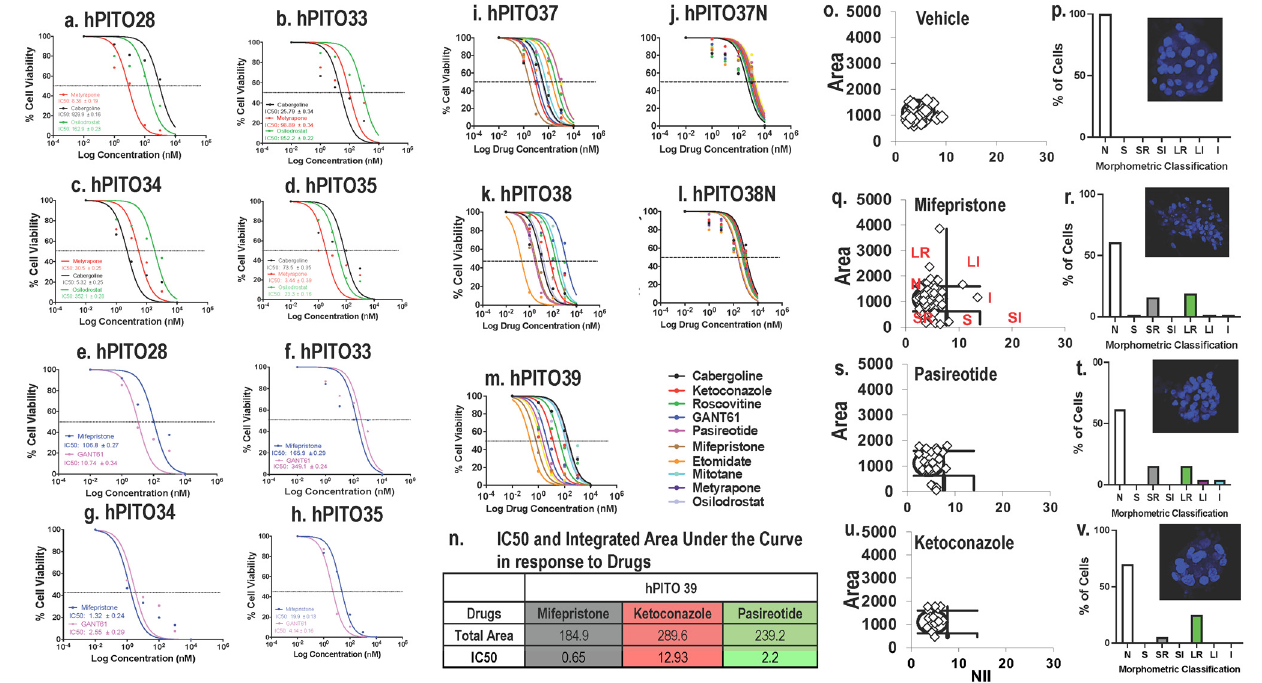
Figure 4. Drug dose responses by hPITOs generated from CD patients. Dose responses to mifepris- tone, GANT61, cabergoline, and osilodrostat. ( a , e ) hPITO28, ( b , f ) hPITO33, ( c , g ) hPITO34, and ( d , h ) hPITO35. Dose responses to cabergoline, ketoconazole, roscovitine, GANT61, pasireotide, mifepris- tone, etomidate, mitotane, metyrapone, and osilodrostat in ( i ) hPITO37, ( j ) organoids generated from adjacent normal pituitary tissue (hPITO37N), ( k ) hPITO38, ( l ) hPITO38N, and ( m ) hPITO39. ( n ) IC50 and integrated area under the curve in response to mifepristone, ketoconazole, and pasireotide using hPITO39 cultures. Nuclear morphometric analysis of hPITO39 cultures in response to ( o , p ) vehicle, ( q , r ) mifepristone, ( s , t ) pasireotide, and ( u , v ) ketoconazole. Morphometric classification of NII was based on the normal (N), small (S), small regular (SR), short irregular (SI), large regular (LR), large irregular (LI), and irregular (I) nuclear morphology. Representative Hoechst staining of organoids in the insets in ( p , r , t , v